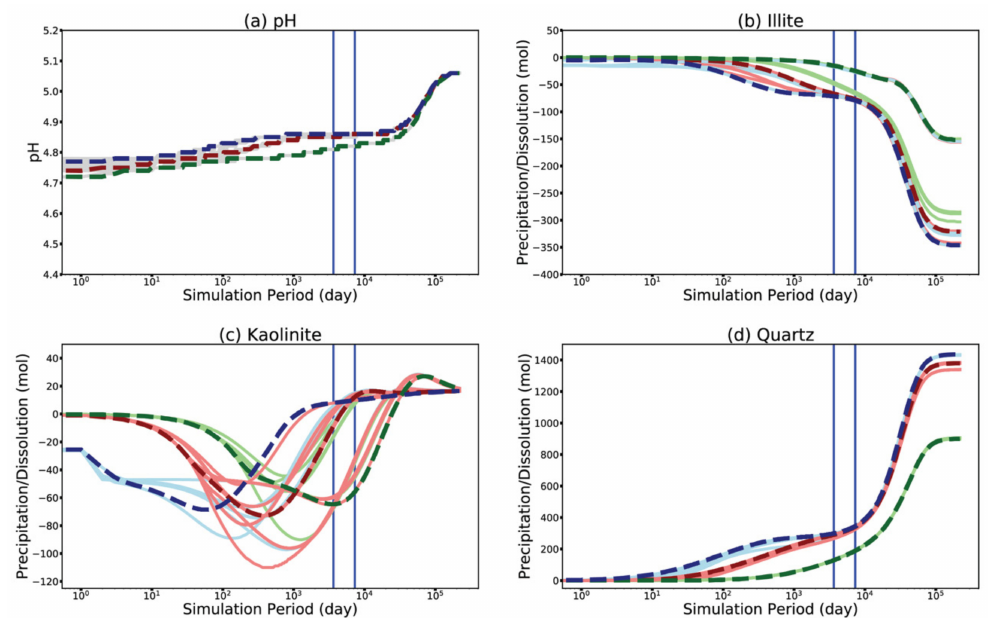
Figure A2. Predicted values from the 2-phase models: ( a ) pH, mineral precipitation or dissolution of ( b ) illite, ( c ) kaolinite, and ( d ) quartz at the center of the model. Light green, light red, and light blue indicate low, mid, and high RSA of the particular mineral in each subplot; dashed lines in dark green, dark red, and dark blue indicate Case#86, Case #85, and Case #87, respectively; two vertical lines denote the end of 10 years and the end of 20 years.